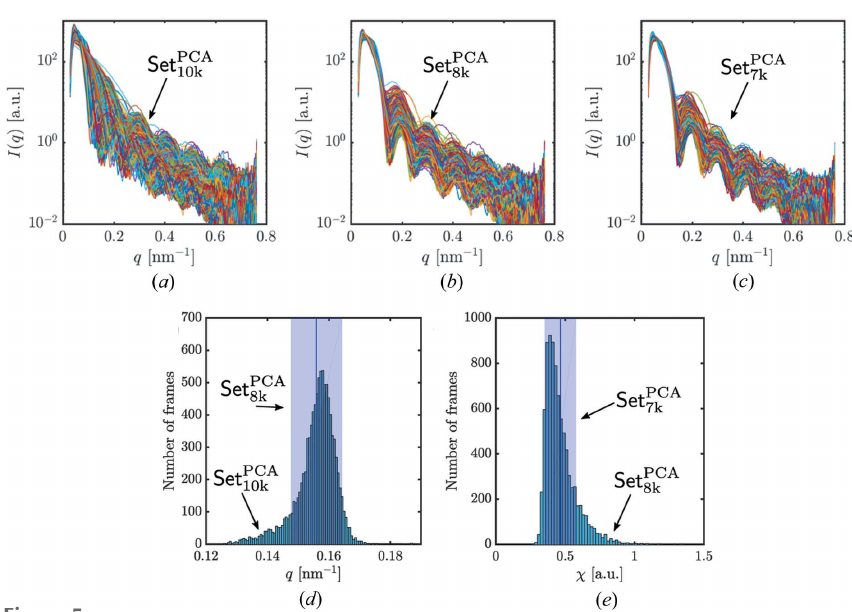
Figure 5 Power spectral density (PSD) for distinct data sets obtained at different stages of particle-size filtering. ( a ) PSDs for the data Set 10kPCA of diffraction patterns. ( b ) PSDs after the size-distribution filtering for Set 8kPCA . ( c ) PSDs after using a restricted fit quality range for Set 7kPCA . ( d ) Histogram of positions of the first minimum from data Set 10kPCA used for the size filtering. Diffraction patterns inside the blue box ( (cid:5) 1 r.m.s. around the mean value) were selected for further analysis. ( e ) Histogram of the PSD fit quality (cid:2) . Diffraction patterns inside the blue box ( (cid:5) 1 r.m.s. around the mean value) were selected for further